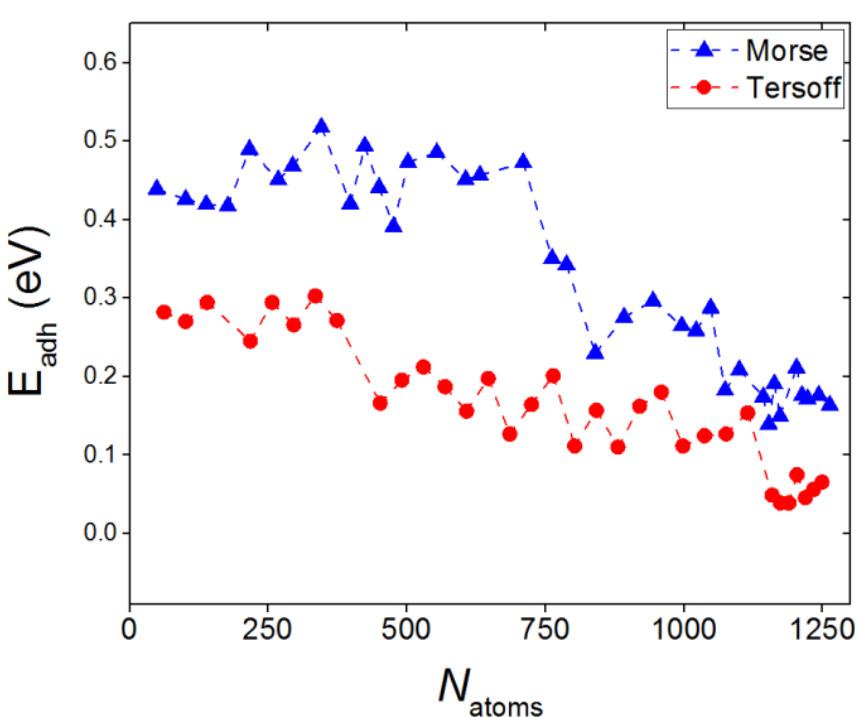
Figure 4. Adhesion energy between SiC films and a graphite substrate as a function of the total number of silicon and carbon atoms at the substrate surface; the values are given for the cases when the “film-substrate” interaction was described by the Morse potential (marked in blue) and the Tersoff potential (marked in red).